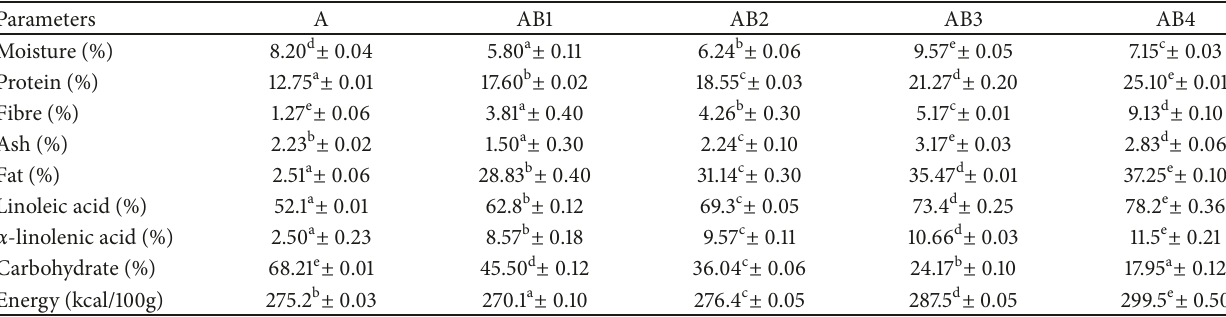
Table 2: Proximate composition of wheat and walnut flour